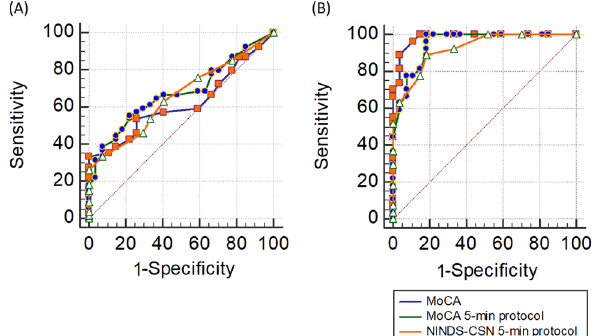
Figure 2. ( A ) ROC analysis (stroke patients vs. healthy controls) and ( B ) ROC analysis (stroke patients with cognitive impairments vs. stroke patients without cognitive